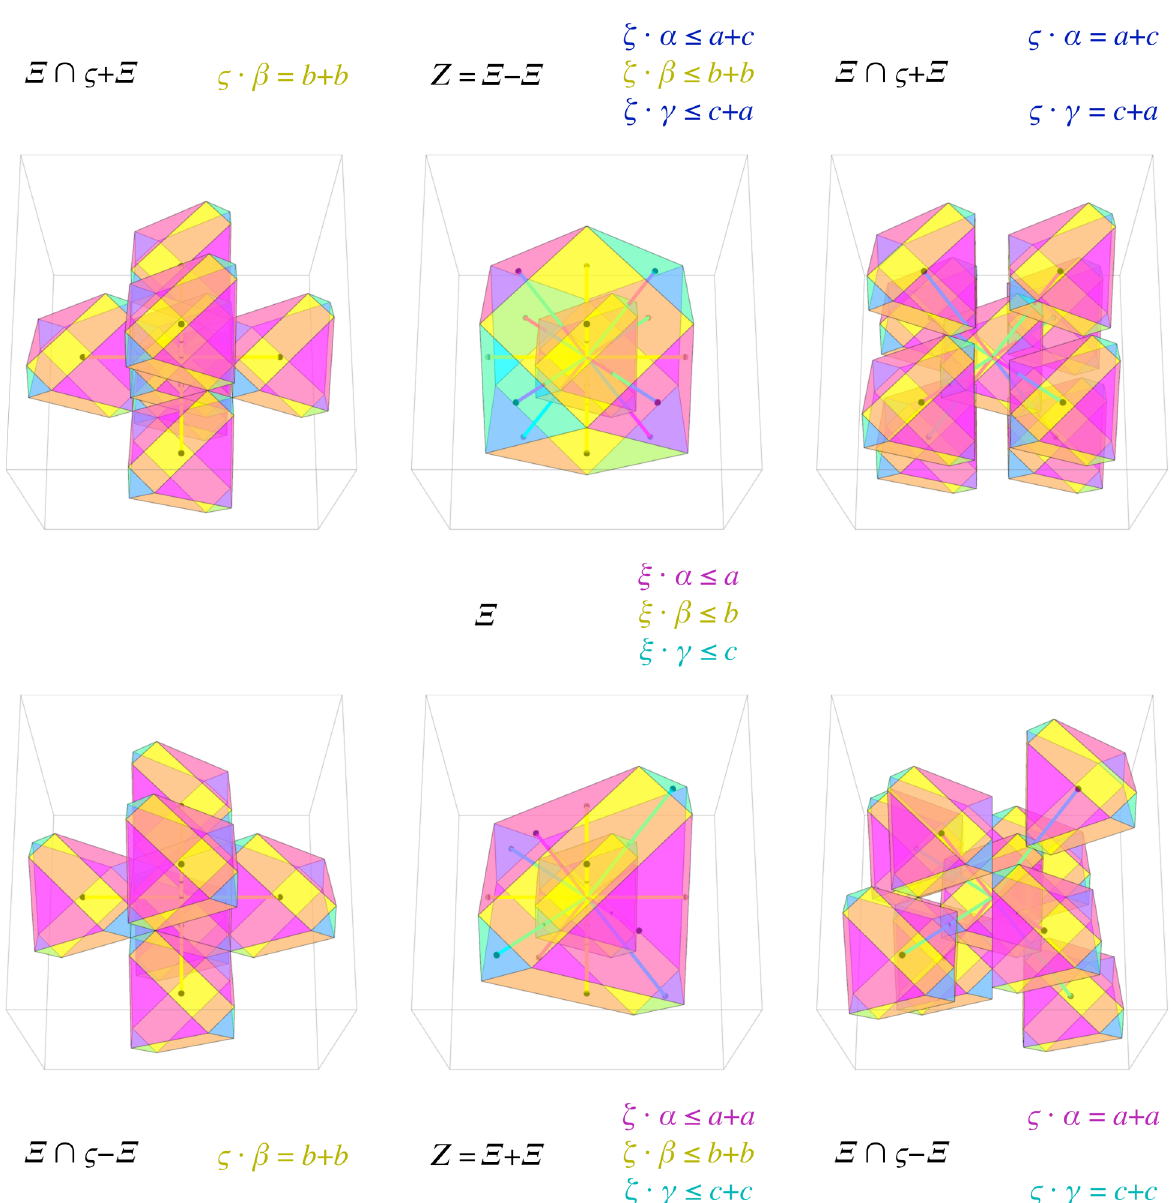
FIG. 11 Sum body 323 þ (top center) and difference body 323 − (bottom center). 323-family face-face contacts: yellow to yellow between antiparallel neighbors (top left), magenta to magenta and cyan to cyan between antiparallel neighbors (top right), yellow to yellow between parallel neighbors (bottom left), and magenta to cyan and cyan to magenta between parallel neighbors (bottom